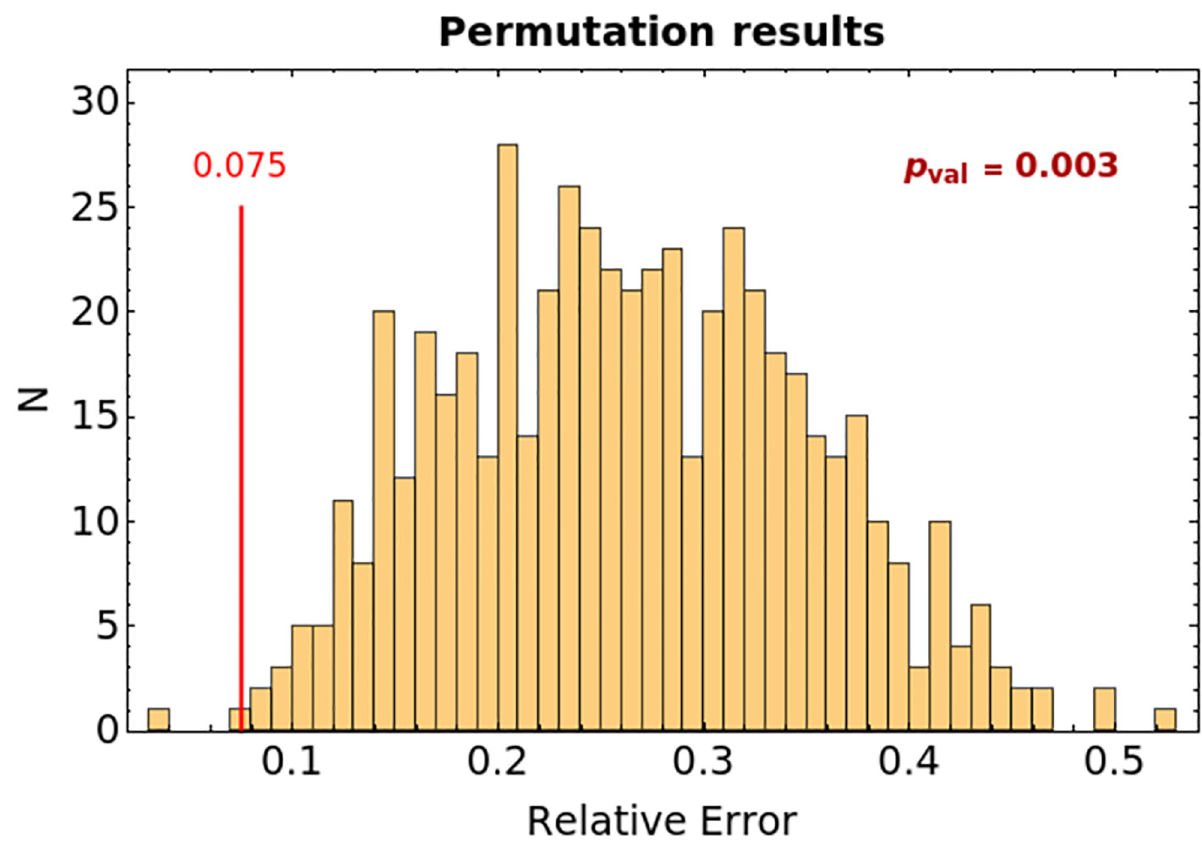
Fig 5. BDT permutation evaluation. Histogram reporting the percentage of misclassified subjects in the permutation test. The red bar shows the performance of the BDT reported in Fig 4. All the misclassification rates are calculated as the average over a 10-fold cross-validation.